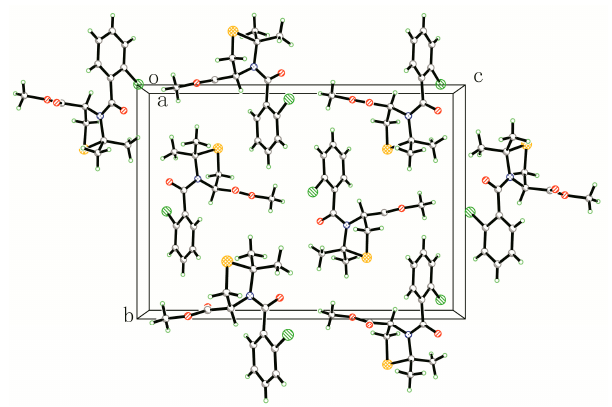
Figure 2. Packing view of Compound 4q . The unit cell axes are labelled as o, a, b, c.